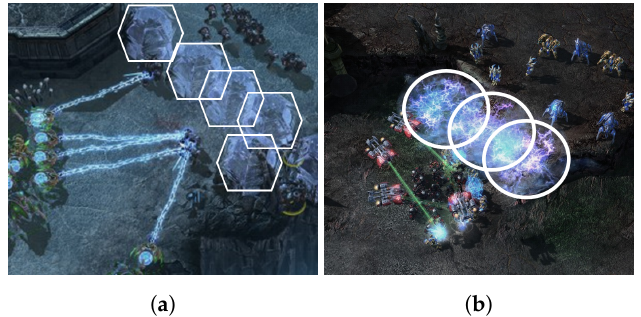
Figure 1. Screenshot images of ( a ) Sentry’s ‘Force Field’ and ( b ) High Templar’s ‘Psionic